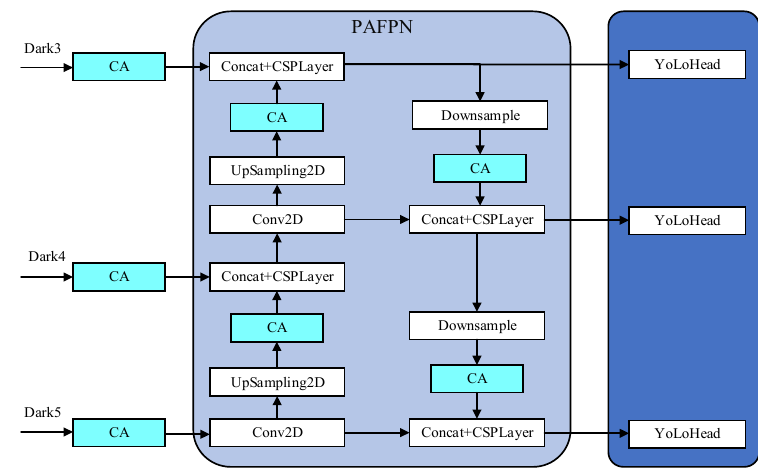
Figure 11. The PAFPN module after being improved.